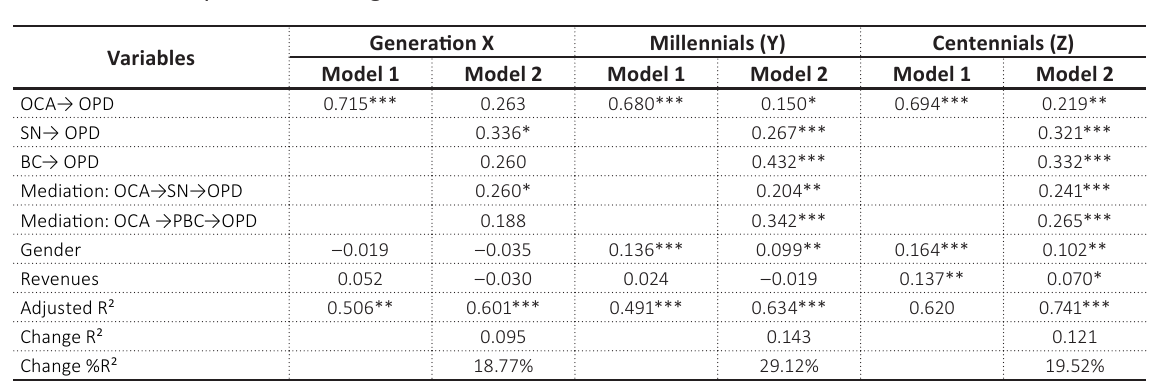
Table 3. Summary of results for generations X, Y, and Z